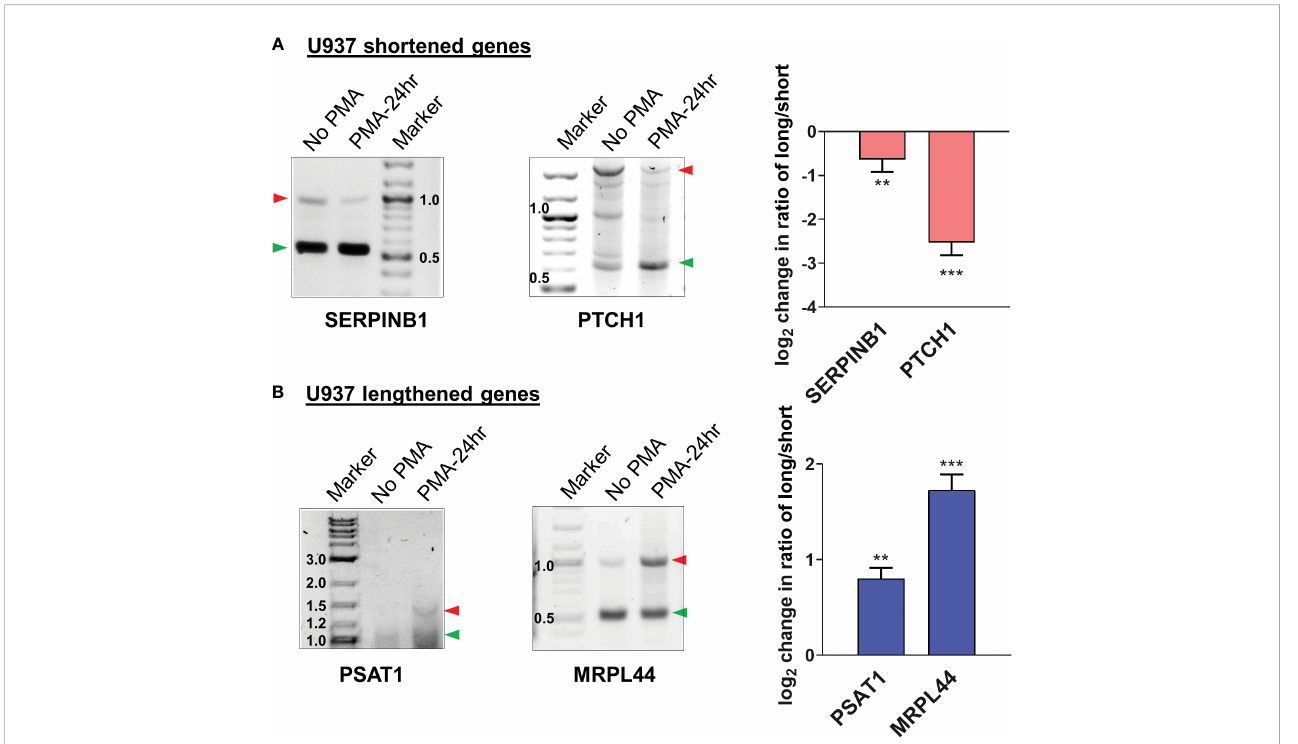
FIGURE 5 Validation of APA events in U937 by 3 ’ RACE. Representative 1% agarose gel images for the 3 ′ RACE RT-PCR from U937 cells (untreated and 24h PMA- treated) for (A) shortened genes SERPINB1, PTCH1 and (B) lengthened genes PSAT1 and MRPL44 using gene speci fi c primers at the last exon-exon junction and a common reverse anchor primer. To con fi rm the direction of the shift in poly(A) site use, normalized intensities of long and short bands for each PCR were quanti fi ed and a long/short ratio determined and normalized to the No PMA control. The corresponding graphs represent mean ± SE from at least two independent experiments. P value <0.05 was considered signi fi cant, where ** = P ≤ 0.01; *** = P ≤